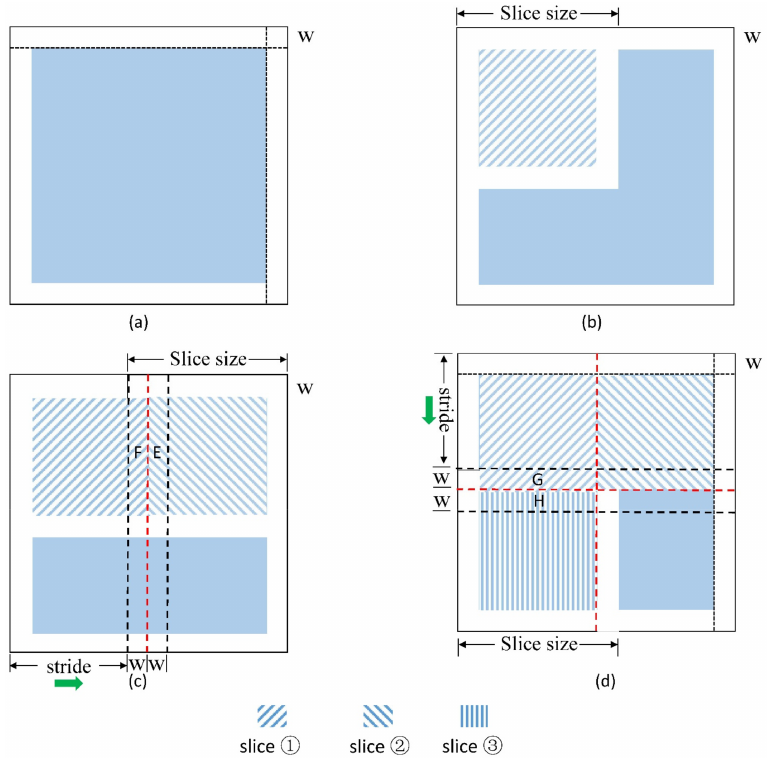
Figure 11. Schematic of sliding slices and discarding edges. ( a ) the original image; ( b , c , d ) the detection process of slice 1 (cid:13) , 2 (cid:13) and 3 (cid:13)